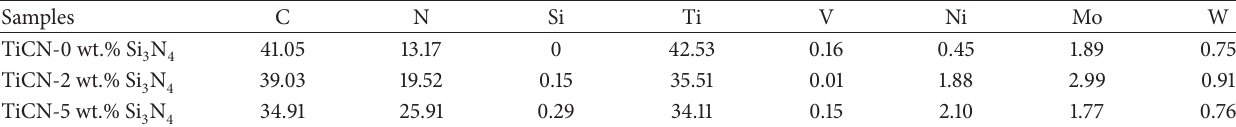
Table 4: Typical atomic content of each element in Particle B.